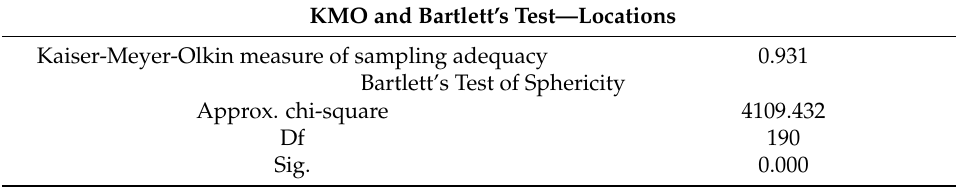
Table 6. KMO and Bartlett’s test for